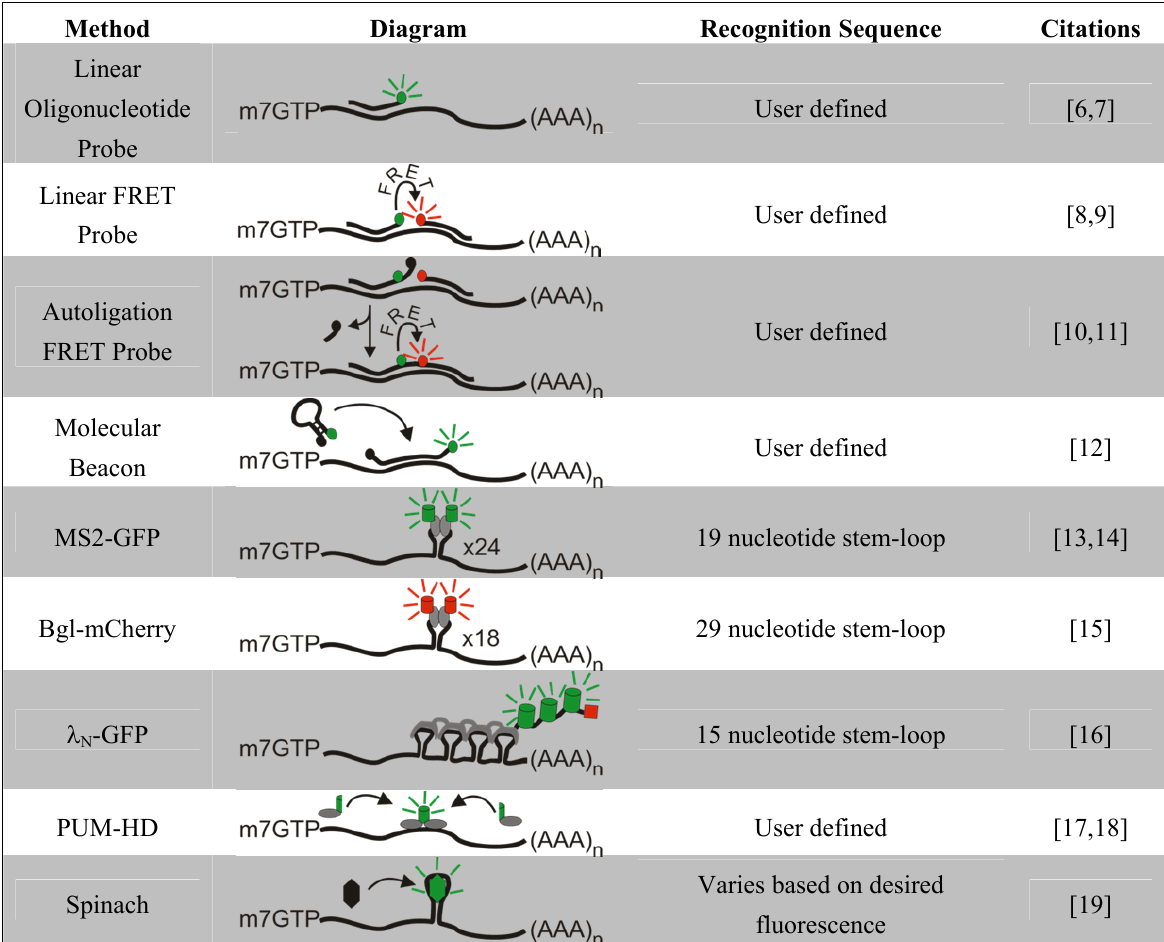
Table 1. Methods to visualize RNA in living